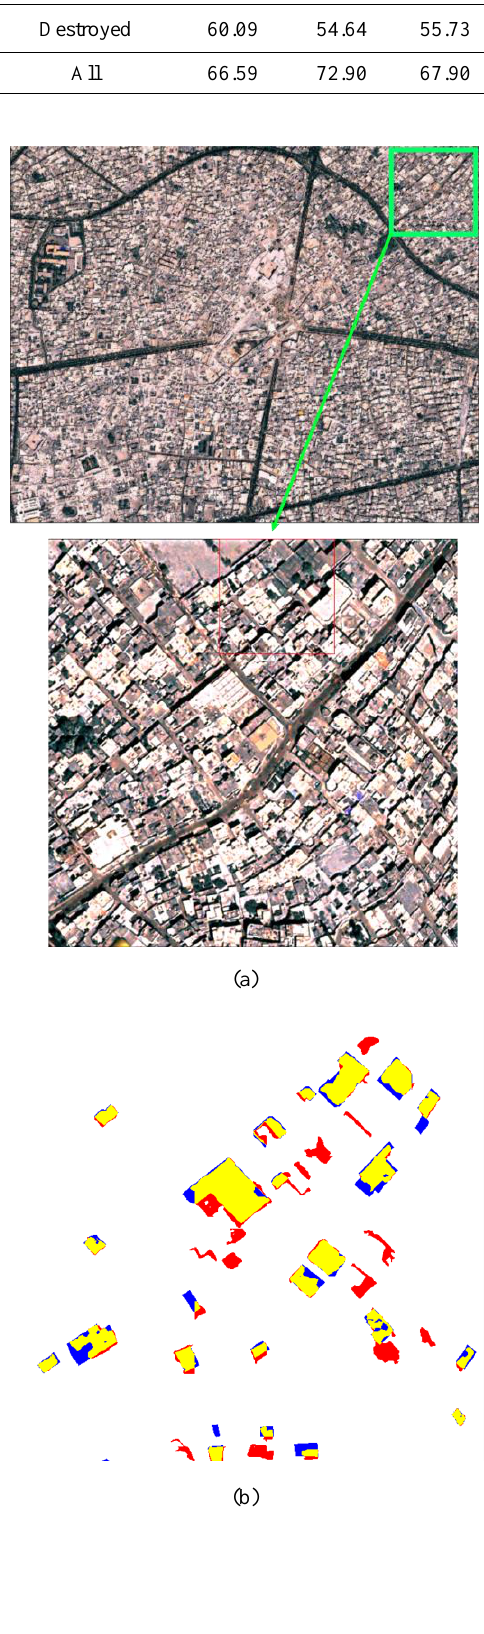
A reference data is manually produced in a small part of the study area. In order to assess the accuracy of the detected changed areas three criteria including, completeness ( E Cm ), correctness ( E Cr ) (Pahlavani et al., 2015), and Kappa ( E Kappa ) (Niemeyer et al., 2013) are employed. The evaluation results of change detection is represented in Table 2 and Figure 8. The yellow area indicates the pixels that are correctly detected, the red pixels indicates the pixels which are wrongly detected and the blue pixels indicates the pixels which are not detected.